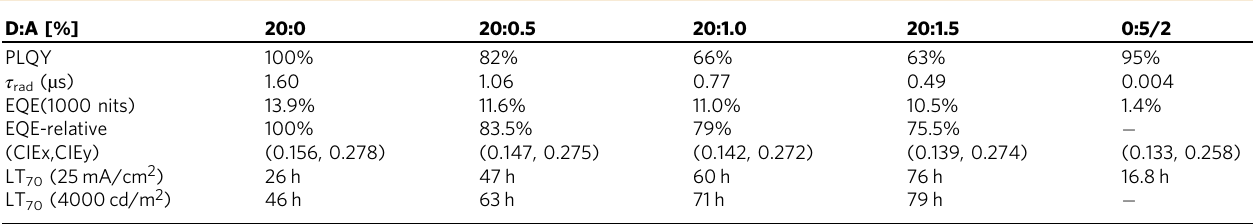
The last column refers to systems without donor, with 5% acceptor for photoluminescent measurements and 2% for light-emitting diodes